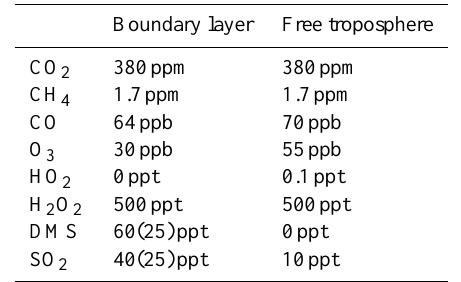
Table 2. Initial trace gas composition of the simulations S 0 and S 1 . Trace gas species not listed here are initialized with zero values. Initial values of S 1 are given in parentheses where they differ from S 0